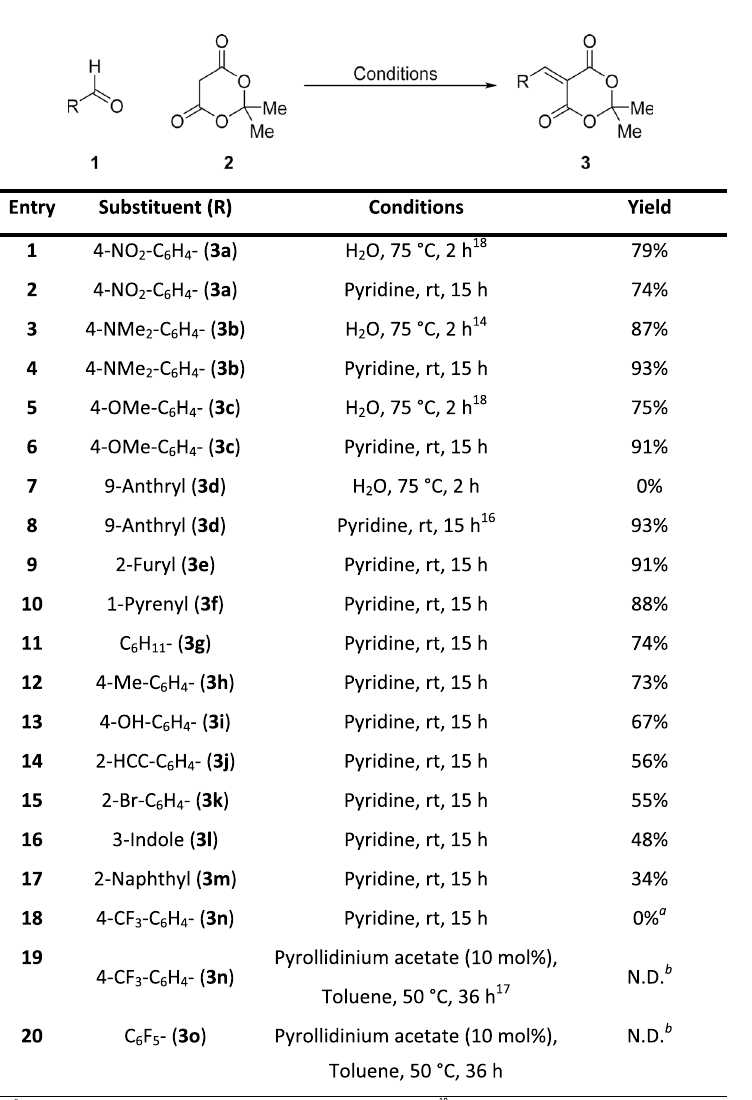
Figure 2. Substrate scope for the Knoevenangel condensation of aldehydes with Meldrum’s